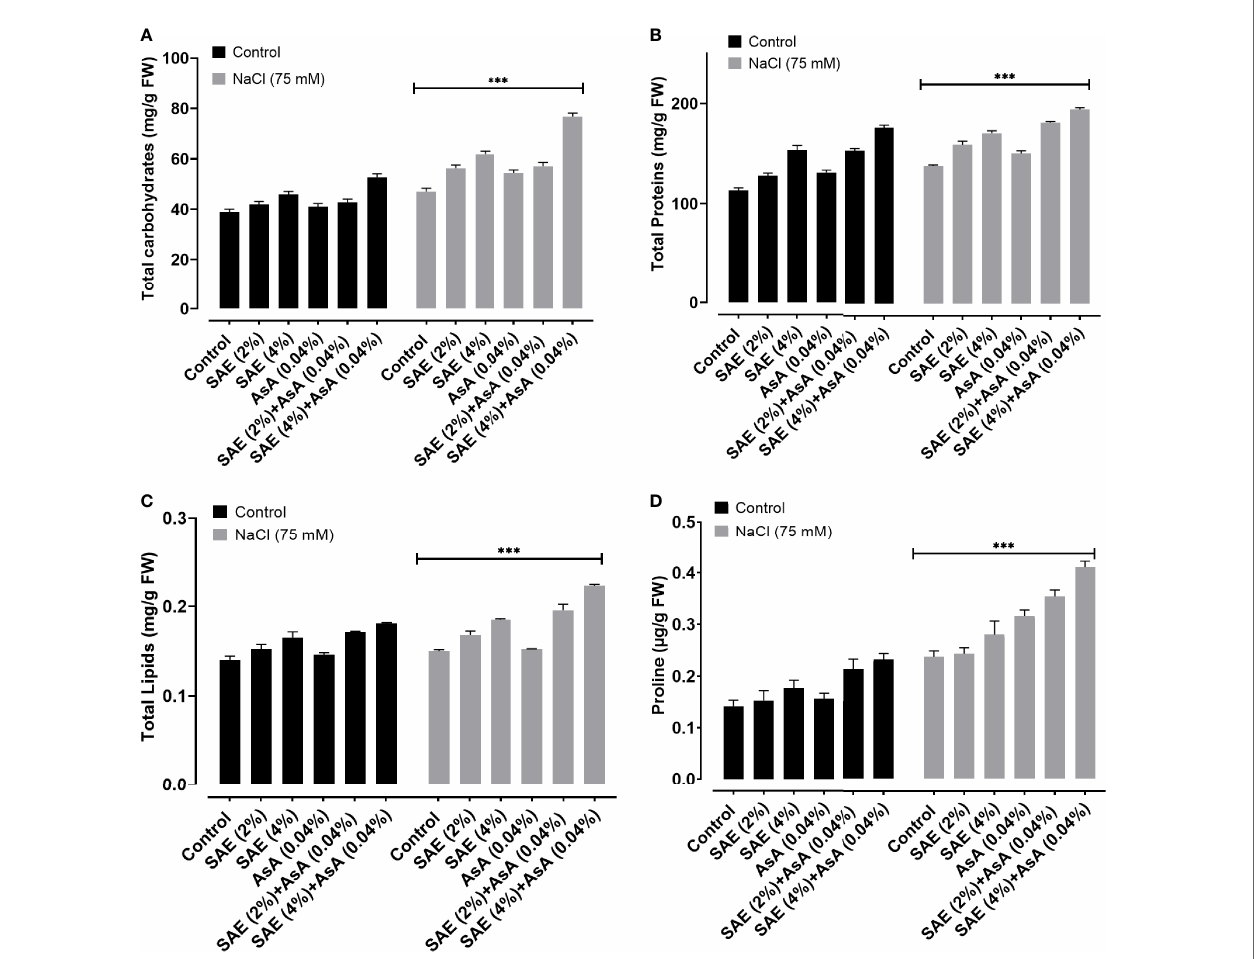
FIGURE 5 | Effect of SAE on primary metabolites of A. esculentus grown under salt stress. (A) Total carbohydrates; (B) total proteins; (C) total lipids; (D) proline content. Error bars of quantitative data represent ± SEM (*** p < 0.005). FW, fresh